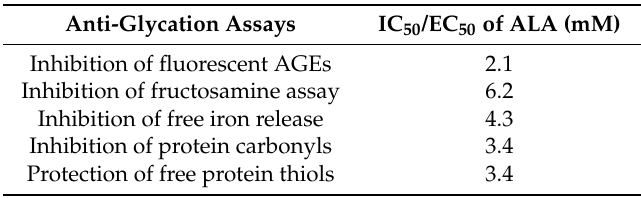
Table 5. IC 50 /EC 50 values of ALA in various anti-glycation